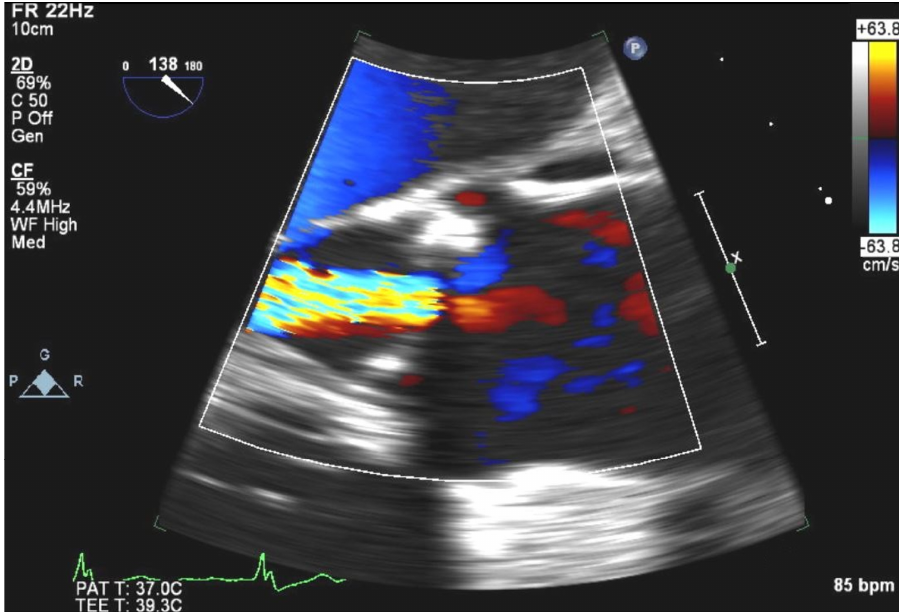
Figure 3. TEE view showing sclerotic aortic valve with moderate aortic valve regurgitation. There was no left-to-right shunting noted. Left atrium appendage (LAA) thrombus (Figure 4) was noted on TEE, attributed to the sub-therapeutic INR, and was deemed unrelated to vegetation as there was no interatrial shunt.